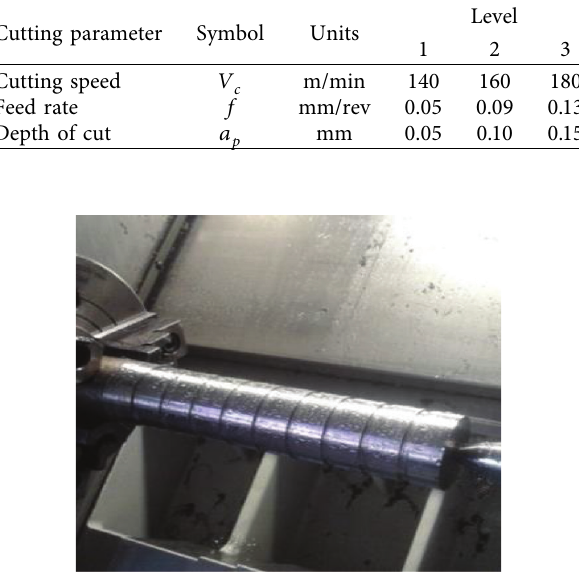
Figure 1: PVD carbide tool 2D